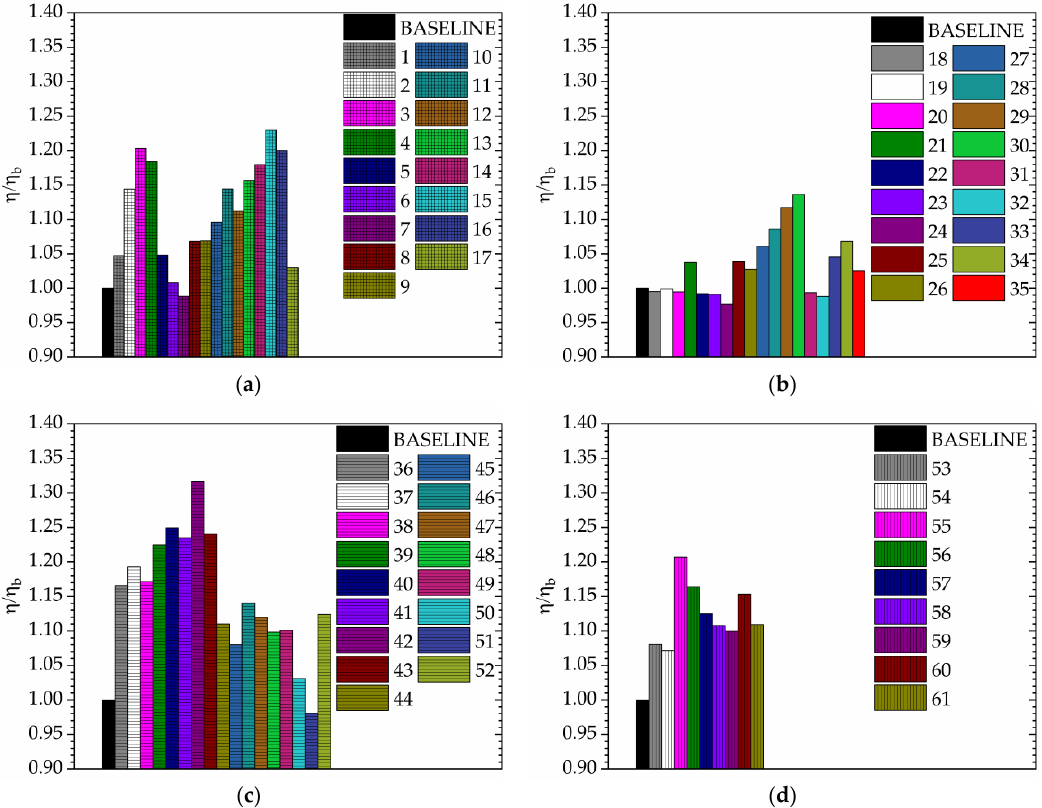
Figure 4. A comparison of the hydrofoil’s power extraction performance at various deflector positions. ( a ) J* = 1/4 shown by square pattern. ( b ) J* = 1/2 shown by no pattern. ( c ) J* = 3/4 shown by horizontal pattern. ( d ) J* = 1 shown by vertical pattern.